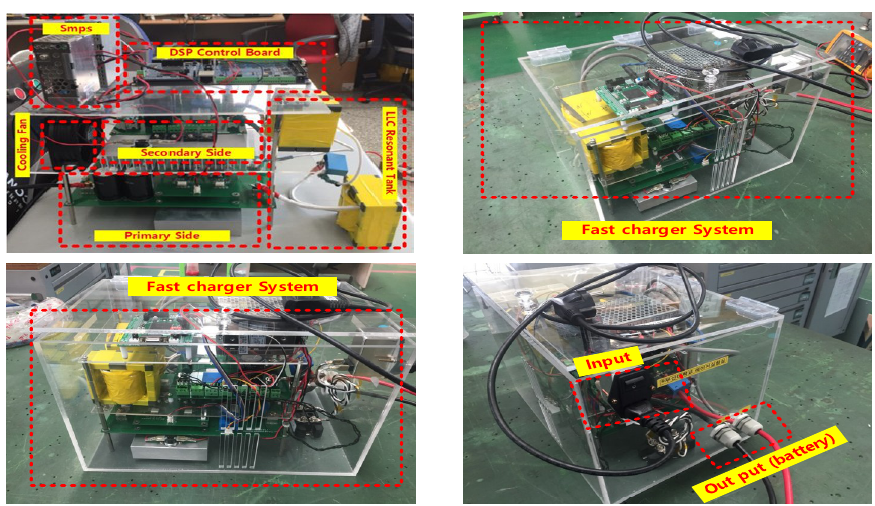
Figure 11. The prototype of the full bridge LLC resonant converter.